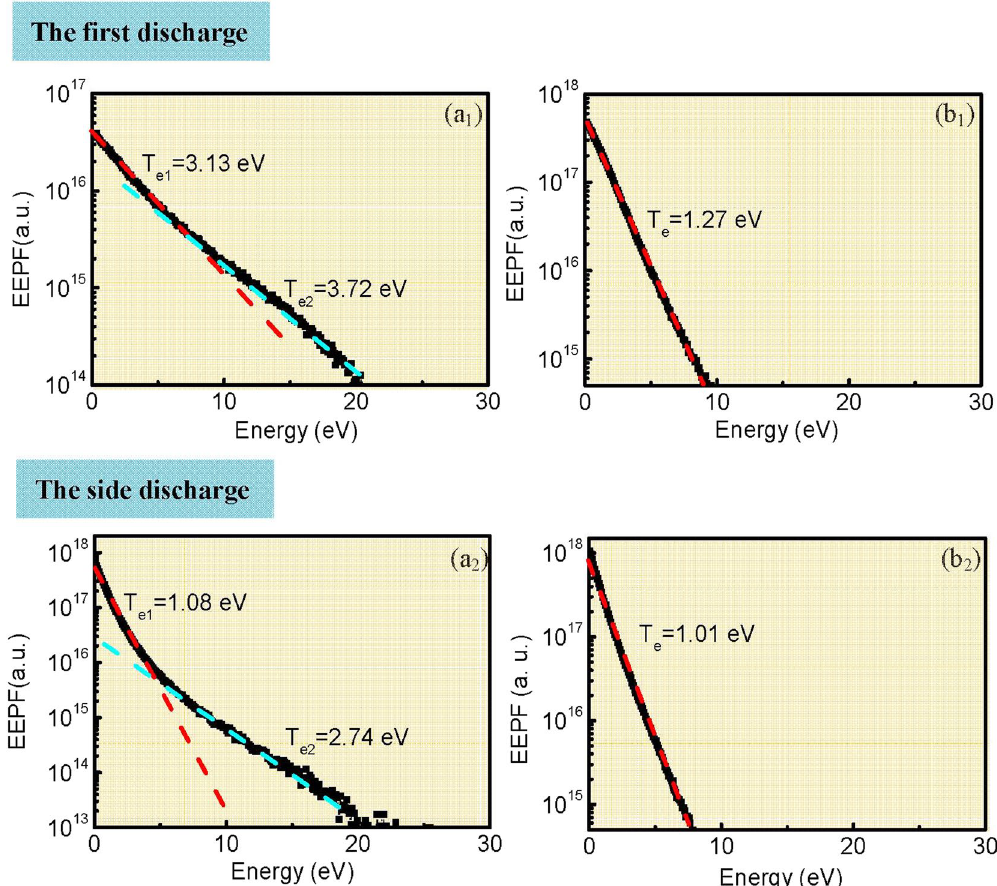
Figure 6. Evolution of EEPFs during the first discharge ( a 1 , b 1 ) and side discharge ( a 2 , b 2 ). The time instants are ( a 1 ) t = 0.72 μ s, ( b 1 ) t = 1.34 μ s, ( a 2 ) t = 1.51 μ s, ( b 2 ) t = 1.97 μ s. In ( a 1 ) and ( a 2 ), the discharge is in the space- charge dominated avalanche phase, while in ( b 1 ) and ( b 2 ), the discharges have expired. T e1 and T e2 denote the low and high electron temperatures,